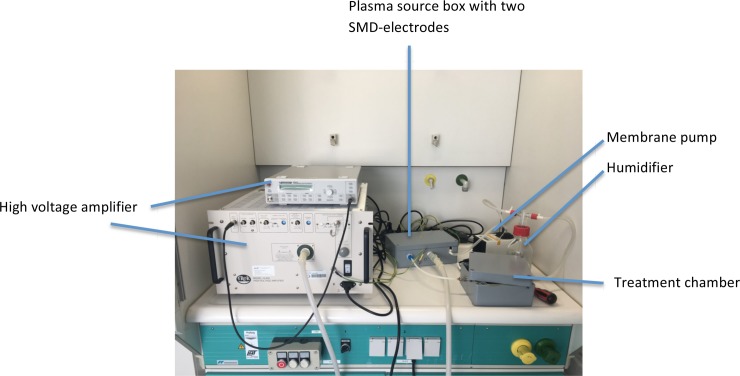
Circular plasma system.